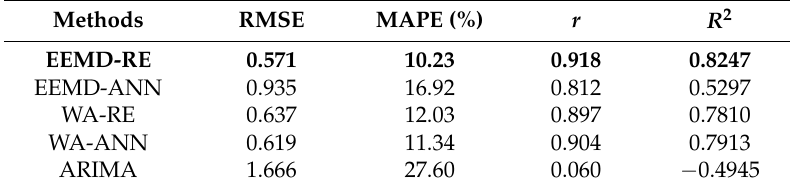
Table 2. Predictive accuracy of statistical results using daily data with 10 days interval.